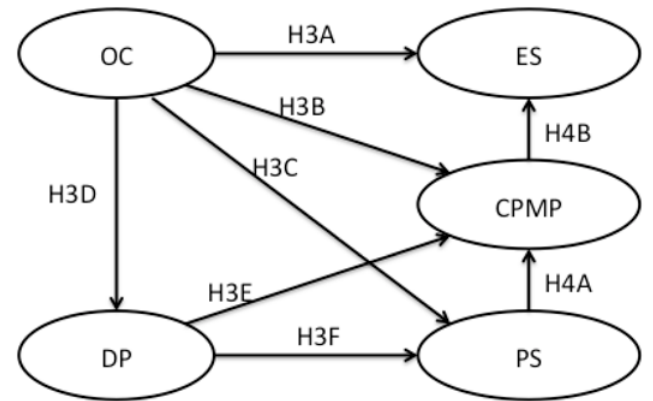
Conceptual model 2